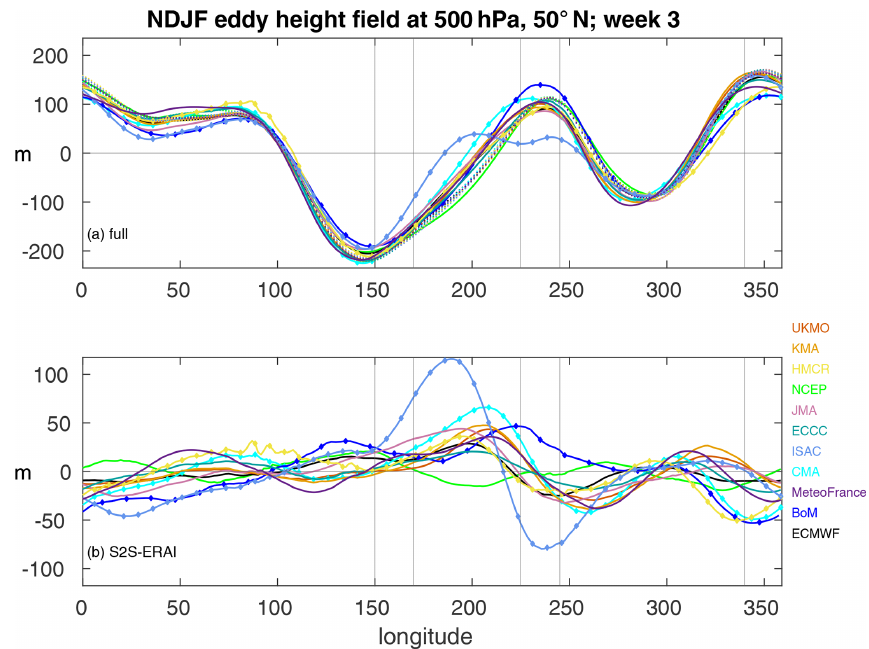
Figure 2. Longitudinal cross-section of 500hPa eddy geopotential height at 50 ◦ N during NDJF for S2S models (solid lines) and ERA-I (dots) in week 3: (a) S2S models (solid) and ERA-I (dashed), (b) difference between S2S models and corresponding days in ERA-I. Vertical gray lines denote the northwestern Pacific, northwestern North America, and North Atlantic regions used for Fig. 3; low-top models are indicated with diamonds.